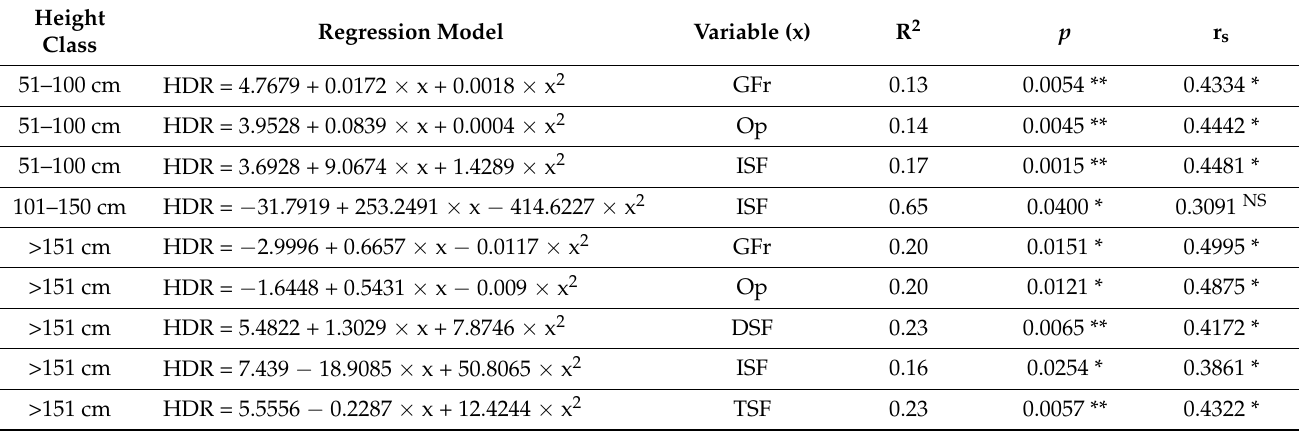
Table A5. Significantly proved regression models of light intensities and the height–diameter ratio of Norway spruce natural regeneration under size-dependent